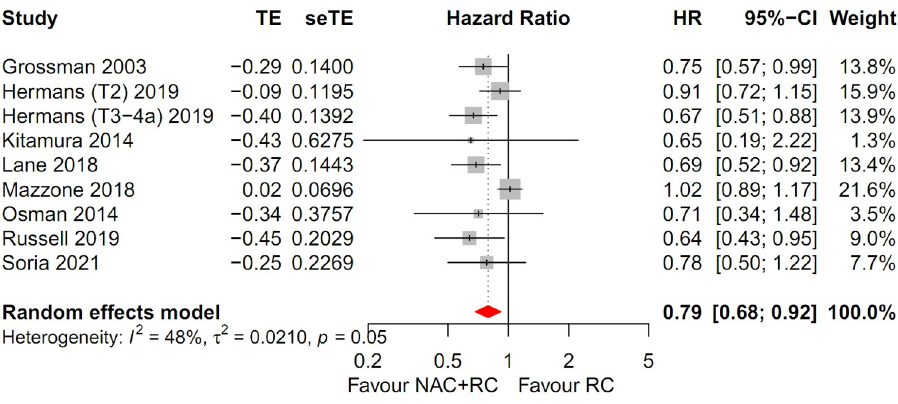
Fig 2. Forest plots for patients with T2-4aN0M0 MIBC. The overall survival was significantly better in the NAC with RC group than in the RC alone group (HR, 0.79; 95% CI, 0.68–0.92; p = 0.002).